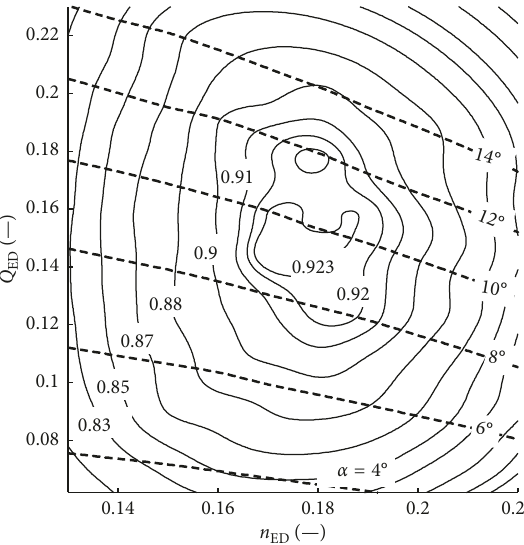
Figure 5: Hill chart of the investigated